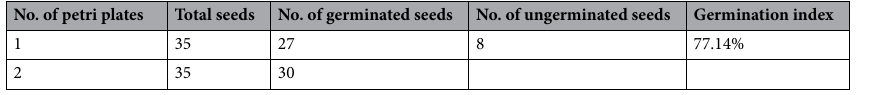
Table 2. Germination